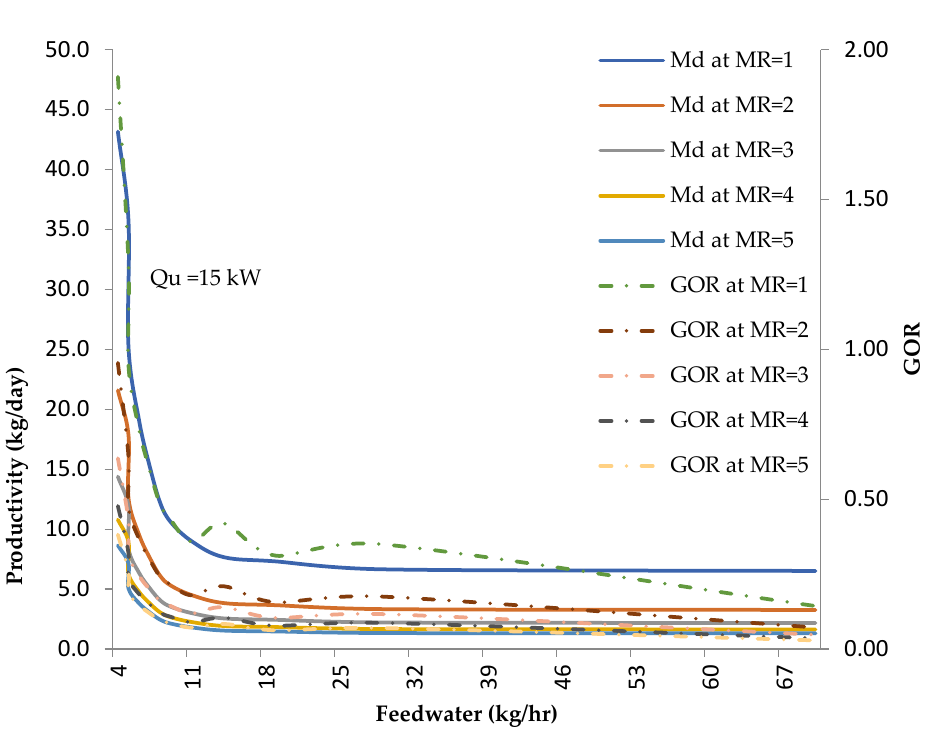
Figure 10. Effect of feed water flow rate on productivity and GOR of the HDH system. As shown in Figure 11, both productivity and GOR are affected by the temperature of the feed water entering the humidifier, as productivity and GOR increase when the input temperature of the feed water is increased due to the increasing evaporation rate.